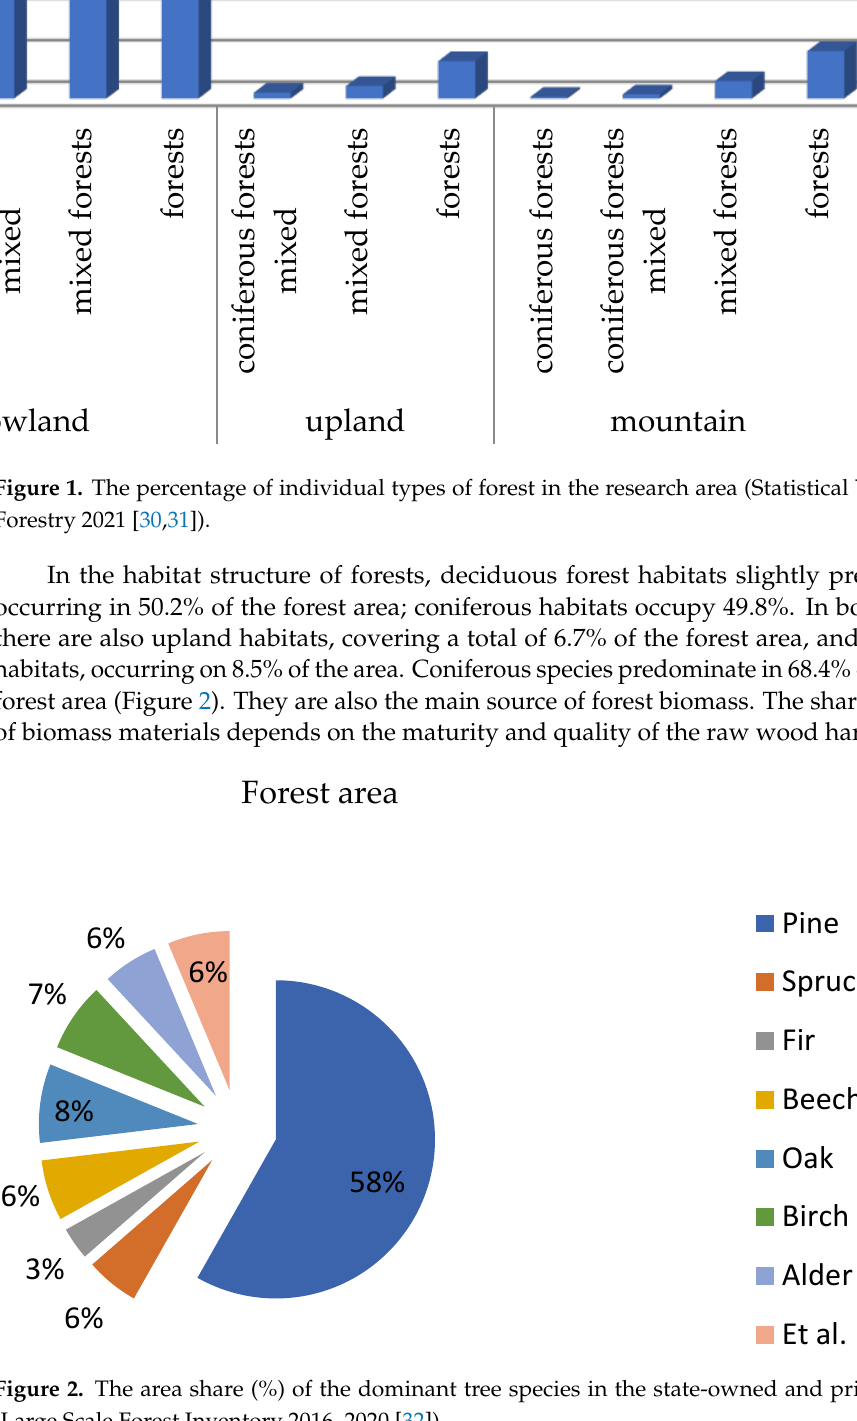
Figure 1. The percentage of individual types of forest in the research area (Statistical Yearbook of Forestry 2021 [30,31]).